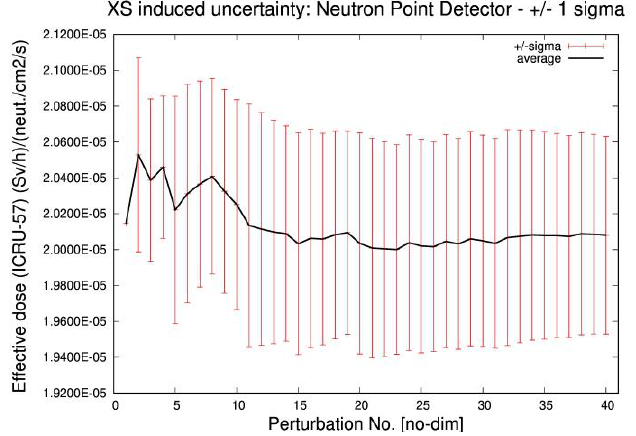
Fig. 12. Converge plot of the mean neutron effective dose and its uncertainty